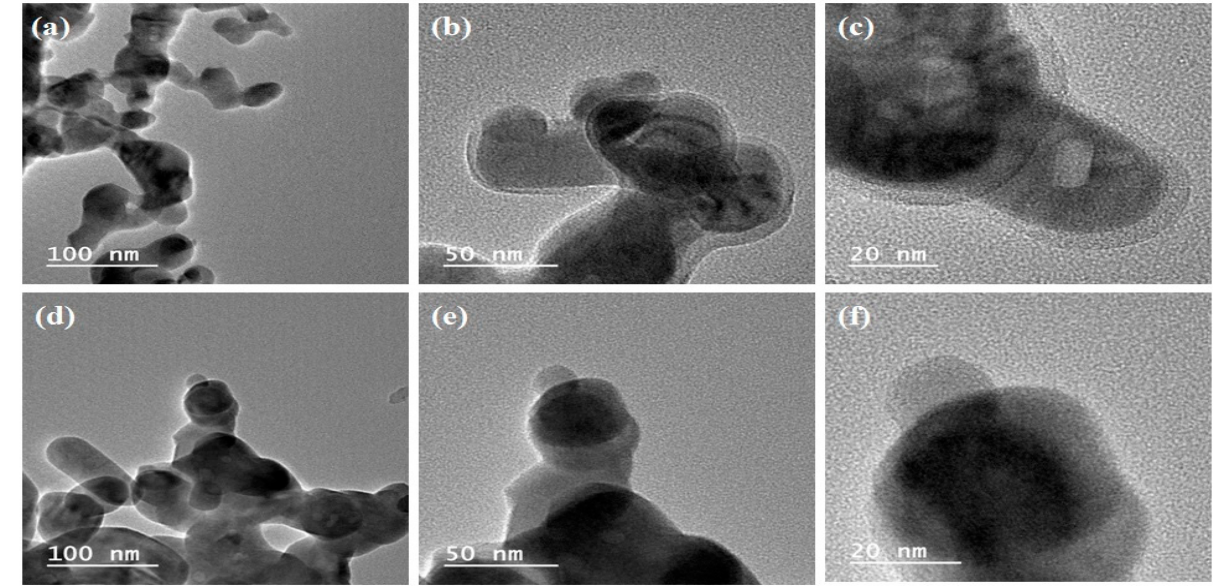
Figure 4. TEM images of Nb2O5 ( a – c ) and Cu-Nb2O5 ( d – f ) .